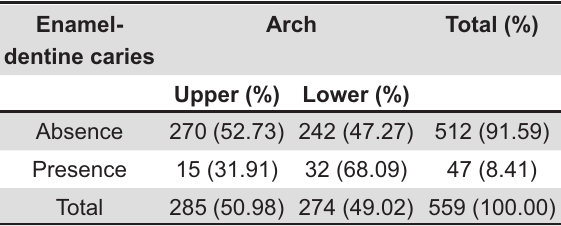
Assessment of enamel-dentin caries lesions detection using bitewing PSP digital Table 4- Distribution of enamel-dentin caries on maxillary and mandibular premolars and molars (p=0.075)